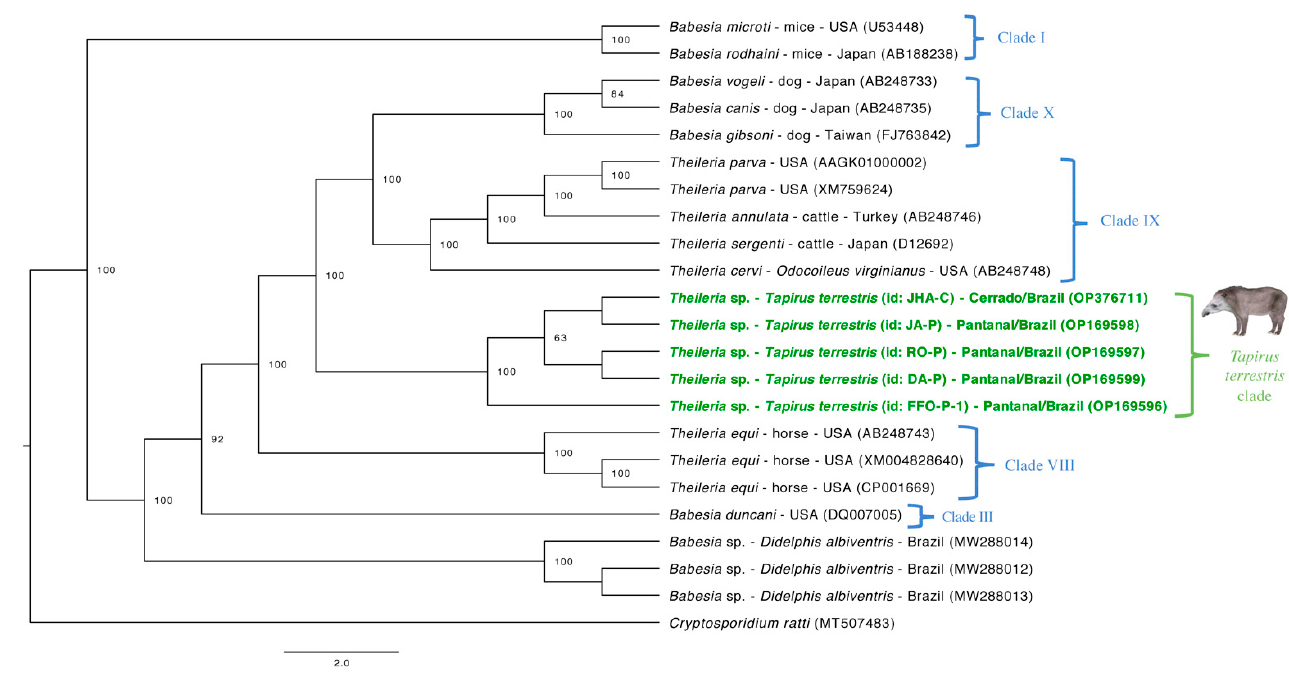
Figure 4. Phylogenetic tree based on partial hsp70 gene. Tree was constructed by Bayesian inference using an alignment size of 690 bp. A sequence of Cryptosporidium ratti (MT507483) was used as outgroup. Sequences from the present study are highlighted in bold. Post probability values >50 appear in tree. Clades (I, III, VIII, IX, X) were identified according to the phylogenetic study of Piroplasmida conducted by Jalovecka et al. (2019) are indicated next to taxa or groups.